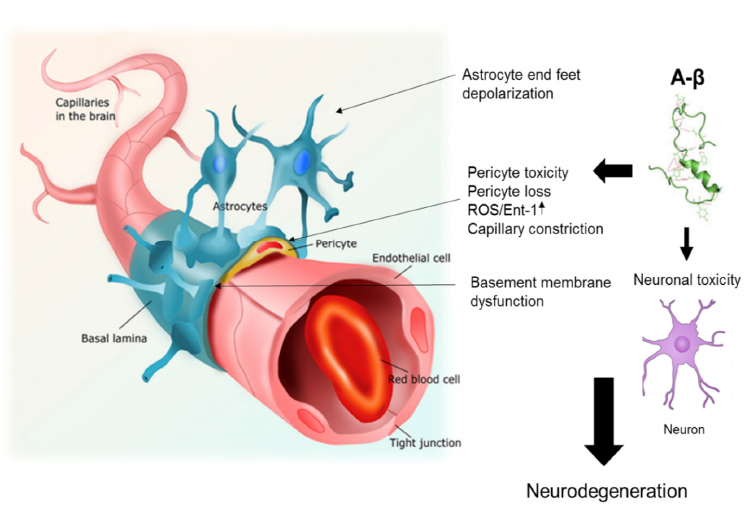
Figure 3. A model of the effects of amyloid beta (A β ) proteins on pericyte function in the neurovascular unit (NVU). The effects of A β proteins on pericytes include pericyte loss, pericyte toxicity, induction of reactive oxygen species (ROS), and capillary constriction, all contributing to neuronal toxicity and neurodegeneration. Figure 3 was revised from previous studies by Alcendor [27]. For the original figure, I acknowledge Pearson Education Inc. (2014).